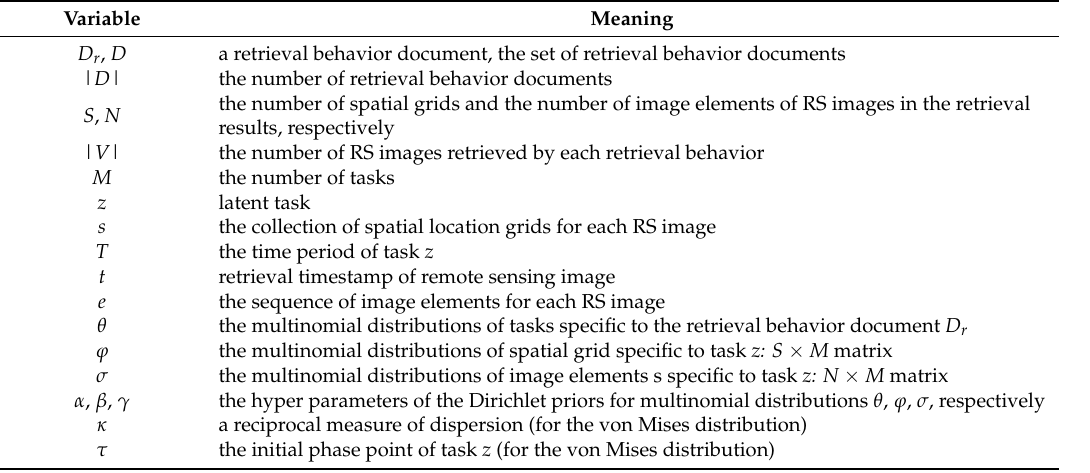
Table 1. Notations in STPT